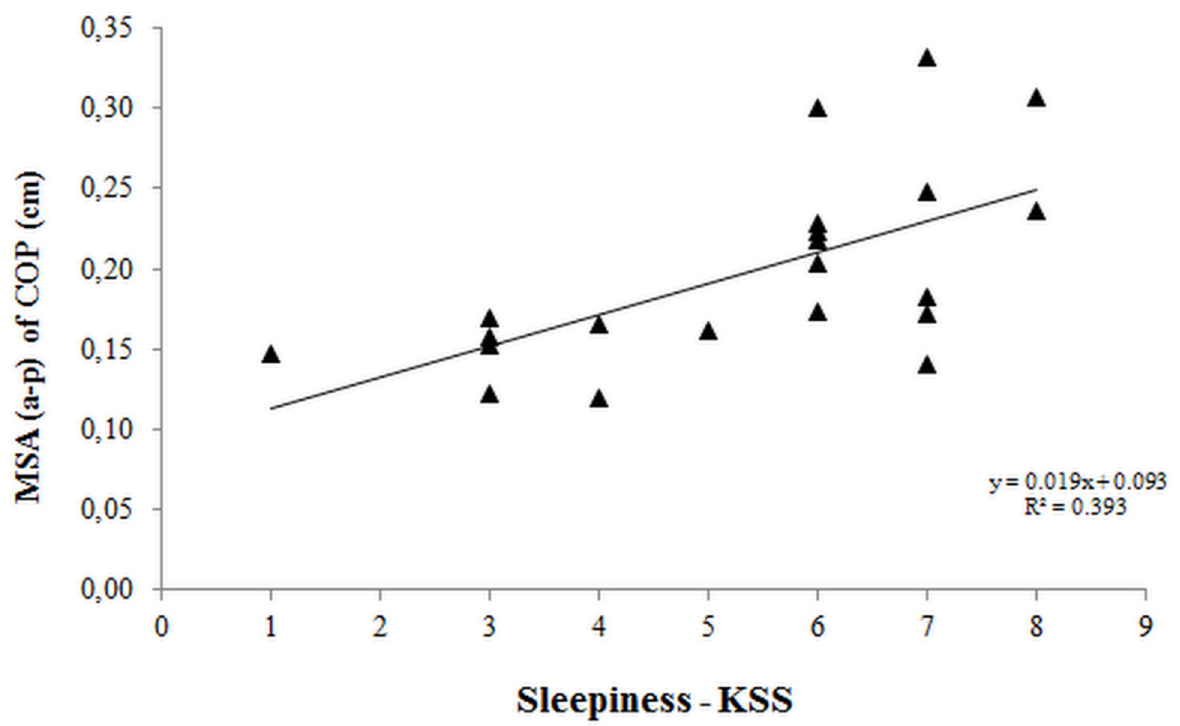
Fig 2. Effect of sleepiness on the mean sway amplitude of the center of pressure in the anterior-posterior direction of 20 night workers assessed by linear regression analysis.